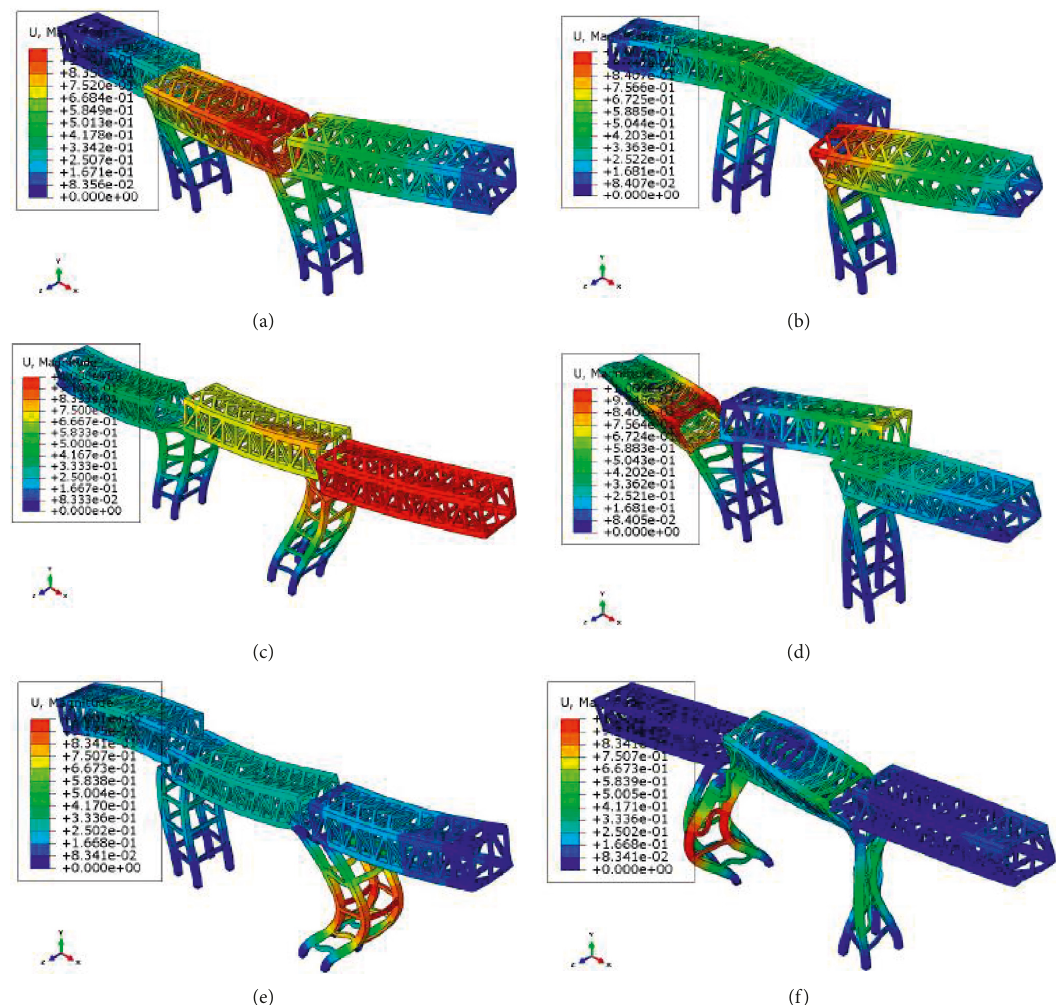
Figure 9: Vibration mode diagram of coal conveying trestle. (a) The first mode. (b) The second mode. (c) The third mode. (d) The fourth mode. (e) The fifth mode. (f) The sixth